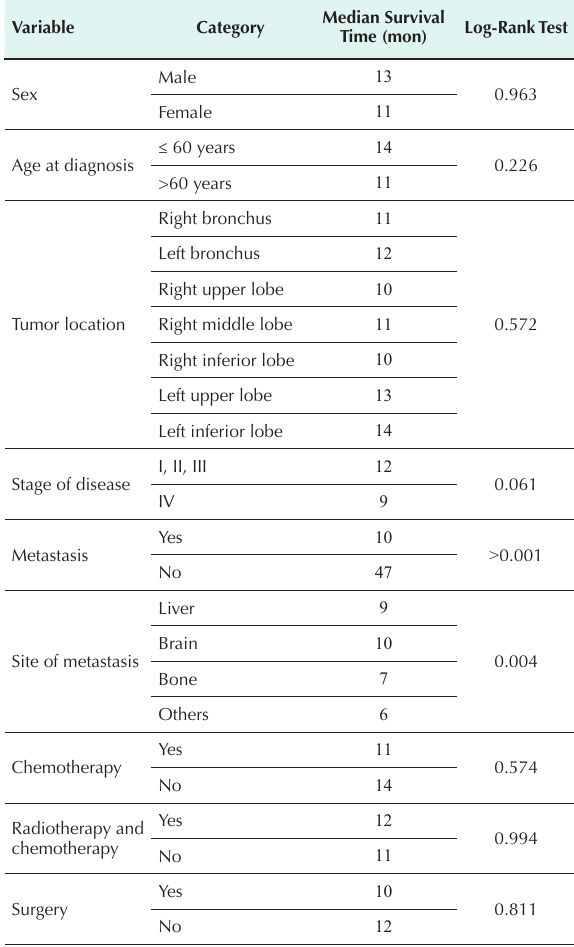
Table 2. Comparison of Survival Rates at the Levels of the Variables Considered in the Present